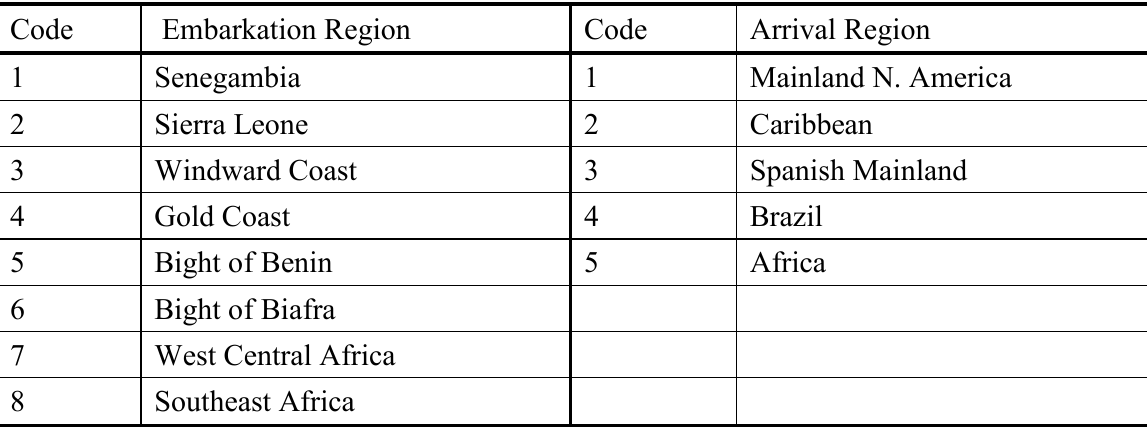
Table 7. Embarkation and Arrival